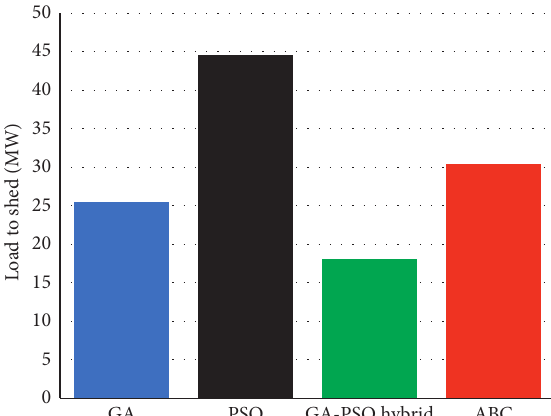
Figure 8: Amount of load to shed